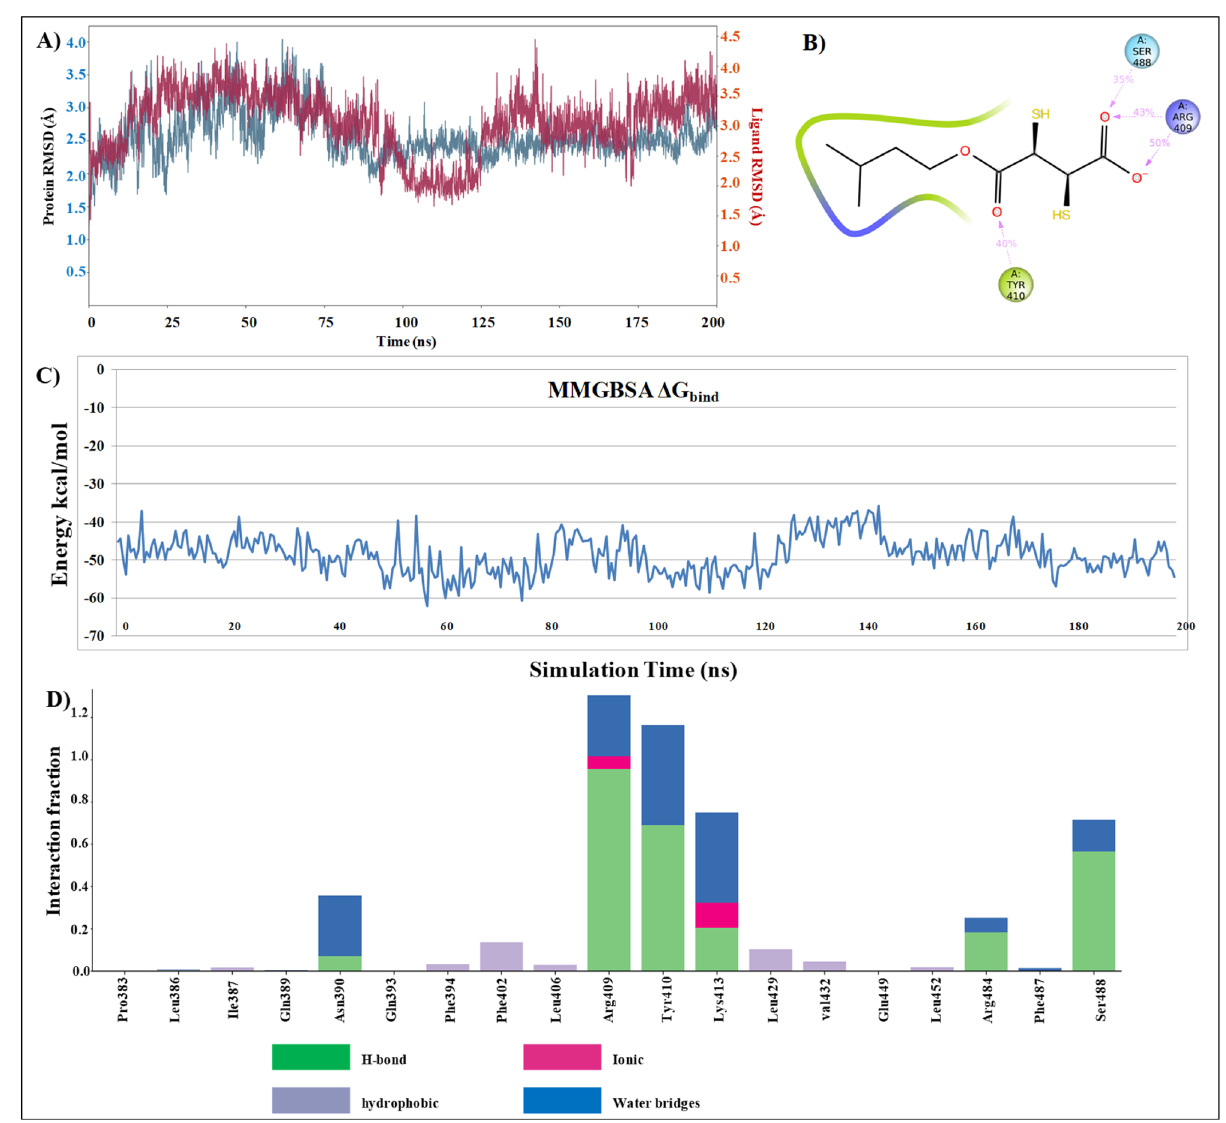
Figure 12. Molecular dynamics result for site II a ( A ) RMSD of protein and ligand ( B ) BSA-MiADMSA interaction diagram during 200 ns of MD simulation ( C ) Binding free energy calculation on 200 ns of MD trajectory ( D ) Interacting residues with their interaction fraction throughout the simulation (Desmond Academic license 2018-4, https ://www.schro dinge r.com/citat ions#Desmo